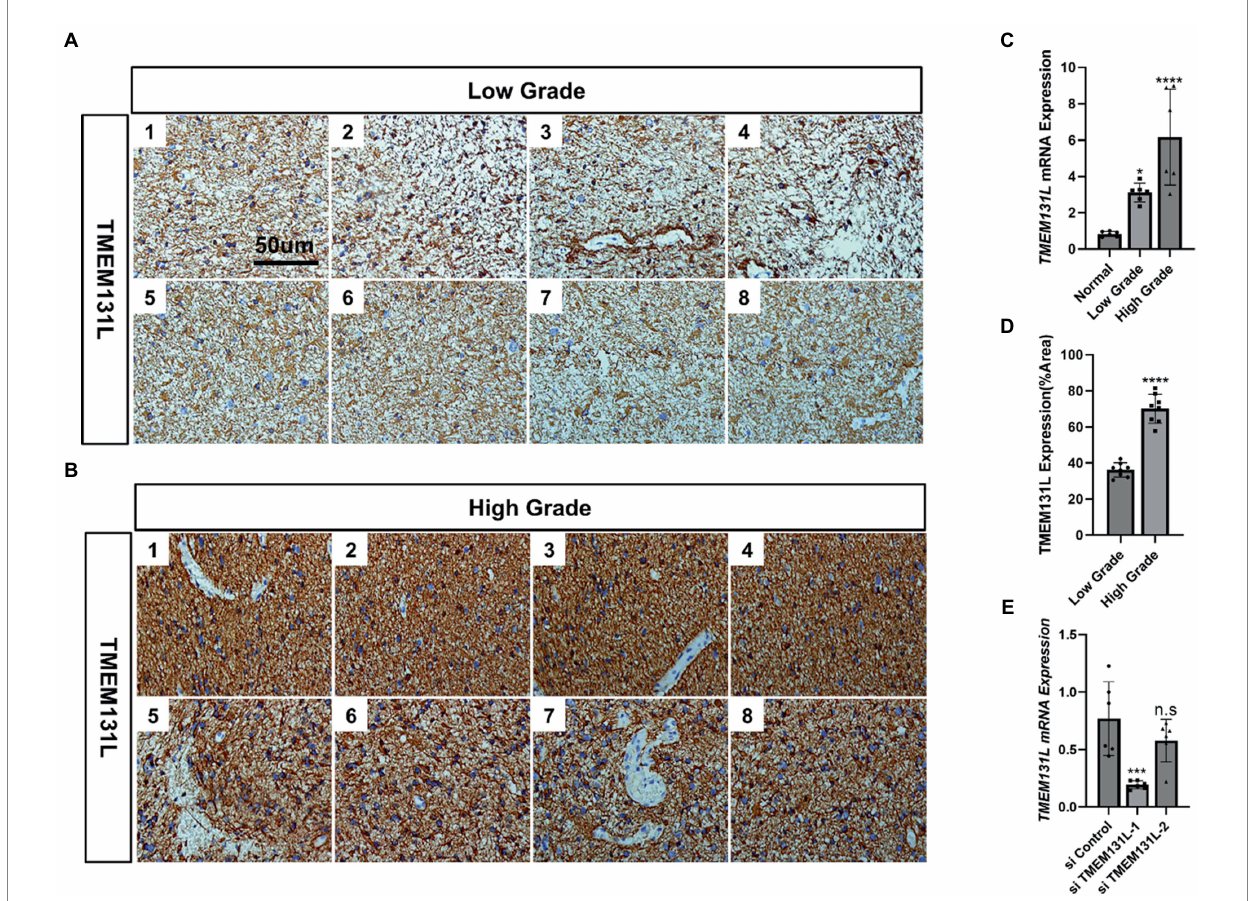
FIGURE 16 TMEM131L is elevated in glioma. (A) Expression of TMEM131L in low-grade gliomas ( n = 8); (B) Expression of TMEM131L in high-grade gliomas ( n = 8); (C,D) The mRNA and protein expression of TMEM131L in low-grade and high-grade gliomas was quantified ( n = 6); (E) Detection and quantification of interference efficiency of si-TMEM131L-1 and si-TMEM131L-2 ( n = 6). n.s > 0.05, **** p ≤